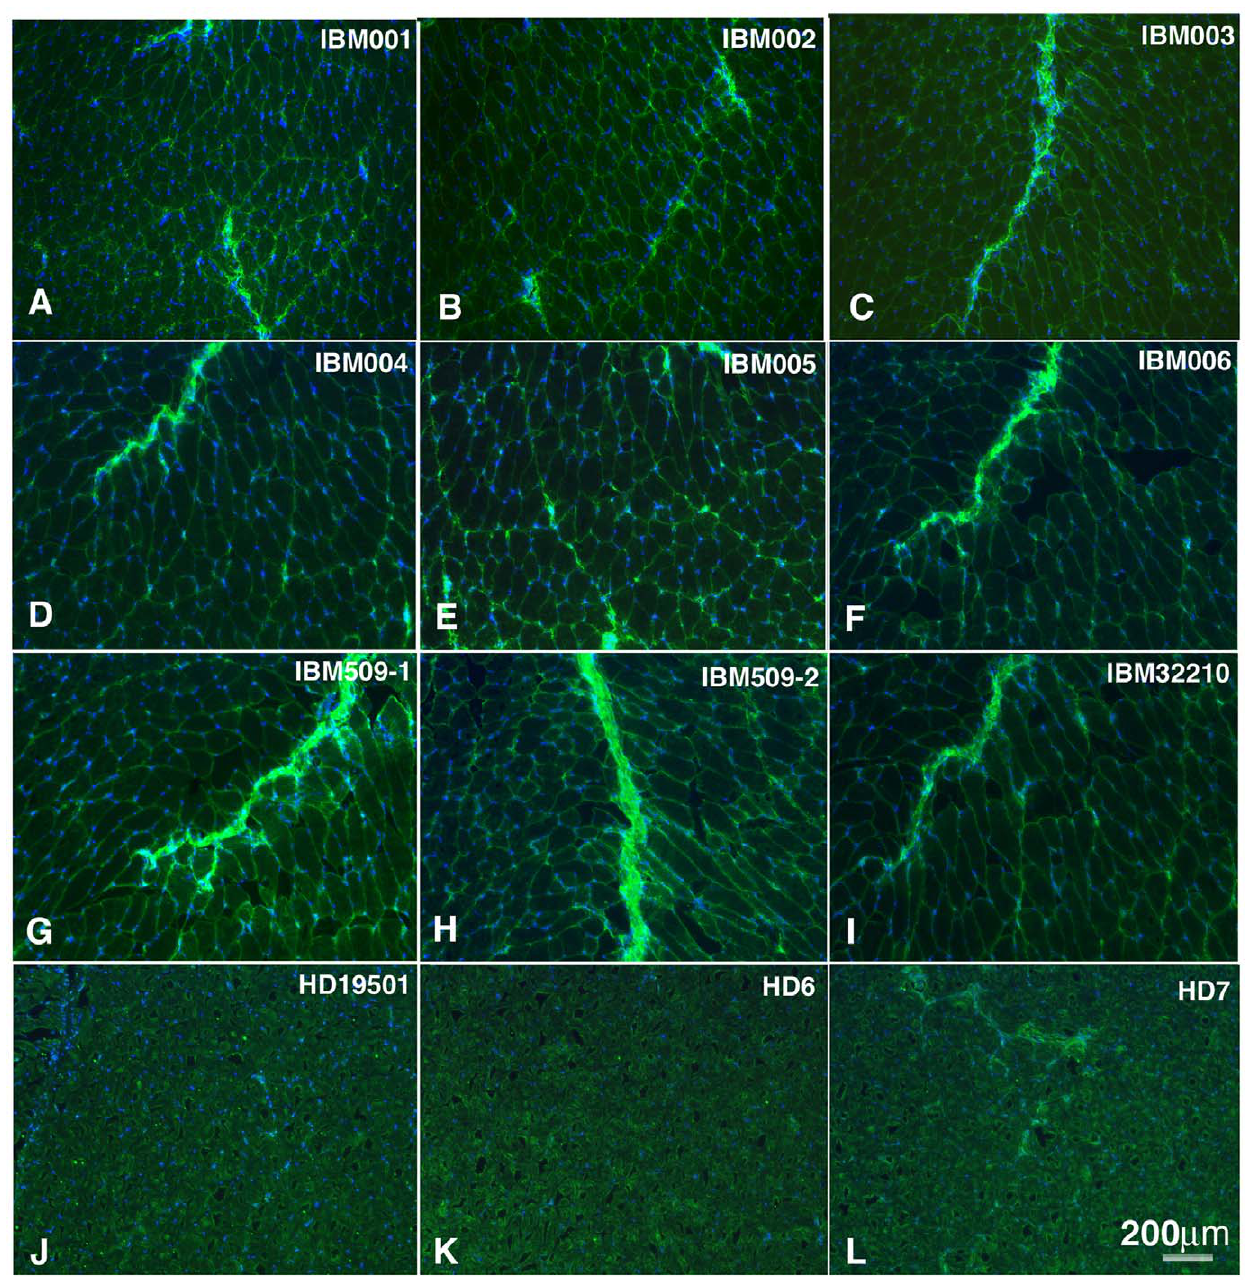
Figure 1. Immunostaining of muscle tissue with serum-derived IgG. Immunostaining of mouse muscle tissue demonstrates IBM-derived IgG positively label muscle tissue sections (A–I). The identity of the IgG specimens is shown in the top right corner of each panel. Staining is present within the endomysial space (green). Nuclei are stained in blue. In sections (A, C, D, F, G, H and I) IBM-derived IgG labeling can be seen in the endomysial space. In six of these samples binding was also observed in the perimysium (C, D and F–I). Tissue, from adjacent sections, stained with IgG derived from healthy donor (HD) serum (J–L) is free of any labeling. doi:10.1371/journal.pone.0046709.g001 showed minimal binding to both permeabilized muscle cell lines and the HOG cell line (Figure 2C). binding (Figure. 2C) to permeablized CCL-136 (3 of 9 (33%)) and CRL-1598 (2 of 9 (22%)) cell lines. The binding of the IBM serum- Taken together, these data further suggest that the peripheral derived IgG to the cell lines CCL-136 (p = 0.005), CRL-1598 circulation of patients with IBM, analogous to other autoimmune (p = 0.009) and HOG (p = 0.009) was significantly different to that conditions, includes autoantibodies that recognize both extra- and of the healthy donor cohort. These IBM specimens were among intracellular self-antigens expressed by human cells, including, but the six that also recognized antigens expressed on the surface of not limited to, those derived from muscle. CCL-136 and CRL-1598 cells. Healthy donor derived IgG (n= 9)